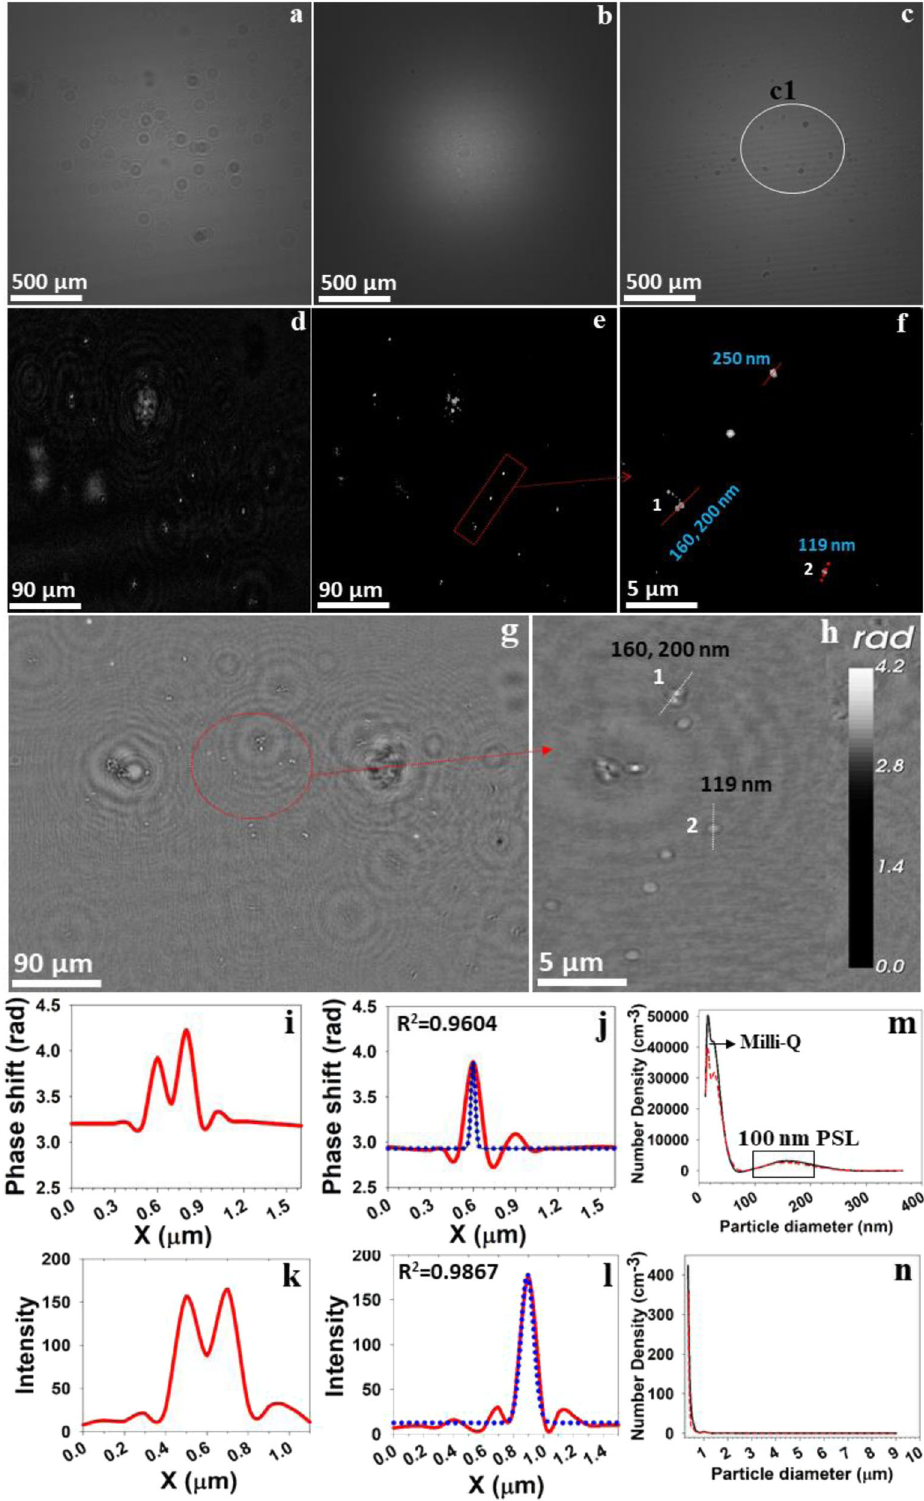
Another con fi rmation for positive observation of 200 nm air- borne PSL particles measured in real time in situ by Nano-DIHM is shown in Fig. 3. The intensity and phase reconstructions of airborne PSL particles are displayed in Fig. 3a – i and their intensity responses across the crosscut of particles are shown in Fig. 3j – m. Nano-DIHM reveals the ~200 nm particles and par- ticles of larger diameter ~1.4 µm (Fig. 3e). In addition, intensity